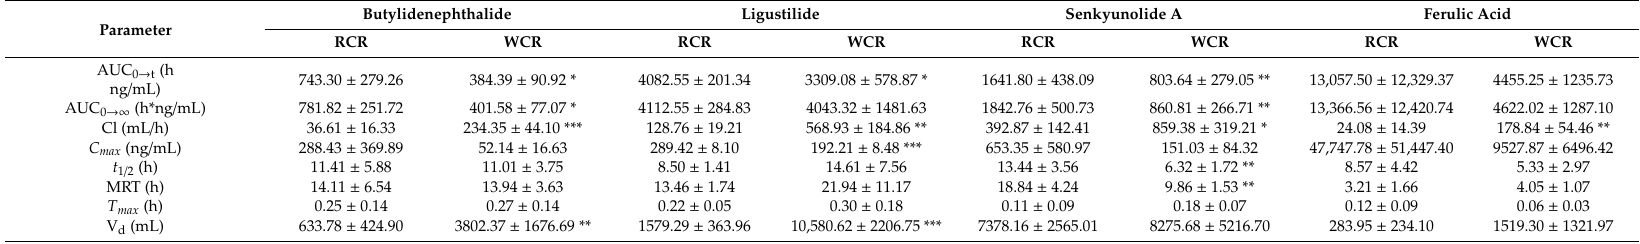
Table 4. Pharmacokinetic parameters of butylidenephthalide, ligustilide, senkyunolide A and ferulic acid after oral administration of RCR and WCR at a dose of 24.01 g / kg ( n = 6, mean ±